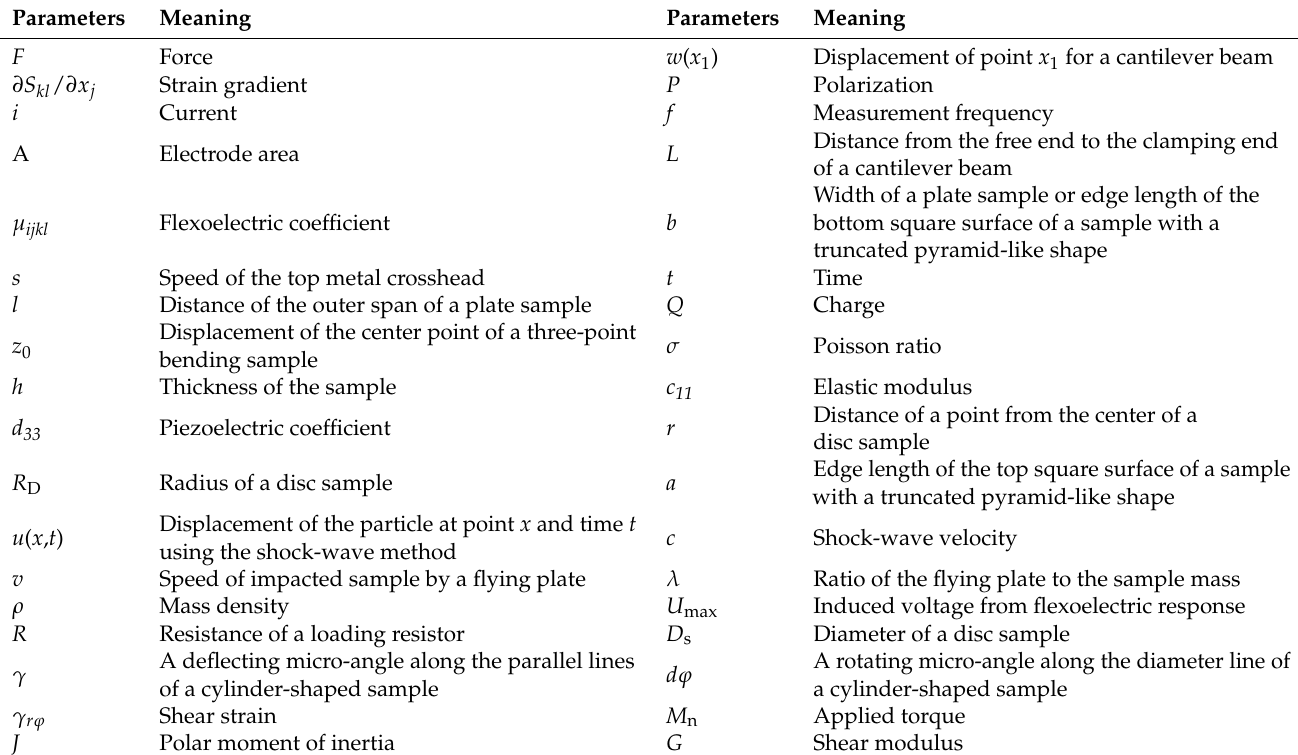
Table 1. Nomenclatures used in Section